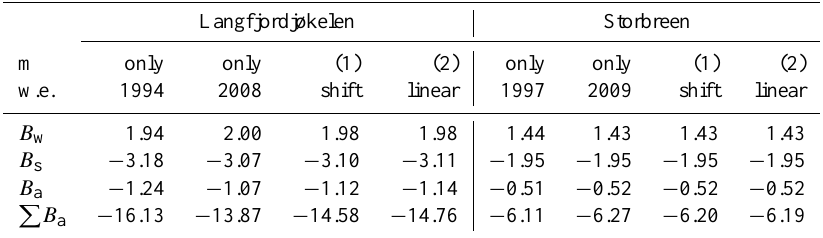
Table 3. Example of sensitivity of mass-balance results of Langfjordjøkelen (1994–2008) and Storbreen (1997–2009) using area–altitude distributions from 2 different years, using only the first year or only the second year throughout, and homogenising them using (1) a stepwise shift (step) halfway through the period or (2) by linearly time weighting (linear) them. B s and B a are averages (mw.e.a − 1 ) for the period of record, and P B a is the cumulative sum of B a for the period (mw.e.). Langfjordjøkelen Storbreen m only only (1) (2) only w.e. shift